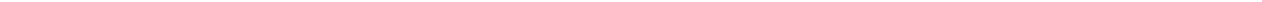
Fig. 3 Crystal structures of the deubiquitinase CsRpn11 and of the CsRpn11 – CsUb complex from the archaeon C. subterraneum . a Structure-based sequence alignment of CsRpn11, S. cerevisiae Rpn11 (ScRpn11), and H. sapiens AMSH-LP (HsAMSH-LP). The color scheme is as in Fig. 2, except that catalytic residues are wrapped in black boxes and that ScRpn11 Gly77 and equivalent residues are highlighted in magenta. Ins-1 and Ins-2 regions (see main text) are shown in cyan, the Ins-1 β -sheets induced by CsUb binding are indicated by arrows. AMSH Ins-2 and C terminus differ from the corresponding elements in Rpn11 and are not shown in the alignment. b The crystal structures of CsRpn11 and CsRpn11 – CsUb, with the active site zinc ion shown in black. The structure of C-terminally truncated eukaryotic Rpn11 from S. cerevisiae (PDB 4O8X) is shown for comparison. The Ins-2 region, which is not resolved in the S. cerevisiae Rpn11 structure, is modeled based on the structure of proteasome-associated human Rpn11 (PDB 5T0C). Residues 174 – 202, including H5, are not resolved in the CsRpn11 structure and the corresponding region is also absent from the truncated S. cerevisiae Rpn11 structure. CsUb is colored gray. c Close-up views of the active site in CsRpn11 crystal structures illustrate the catalytic mechanism 16 . The CsUb-free CsRpn11 structure (left; PDB 6FJU) represents the substrate-accepting state. The transition state is modeled: Upon CsUb binding, the catalytic water performs a nucleophilic attack on the Gly78 carbonyl carbon (middle left; CsRpn11 – CsUb (PDB 6FNO), shown with the Ub backbone of AMSH-Ub 2 (PDB 4NQL 16 ) aligned to CsUb (not shown)), yielding processed CsUb (middle right; PDB 6FNN). Binding of a new catalytic water molecule regenerates the active site and possibly facilitates CsUb dissociation (right; PDB 6FNO). d , e Critical interactions between CsRpn11 and CsUb in the same orientation as in b . Shown are hydrophobic contacts between CsUb and CsRpn11, and the backbone coordination of the CsUb C terminus that results in β -sheet formation in the Rpn11 Ins-1 site. For simplicity, only side chains that are involved in these contacts are